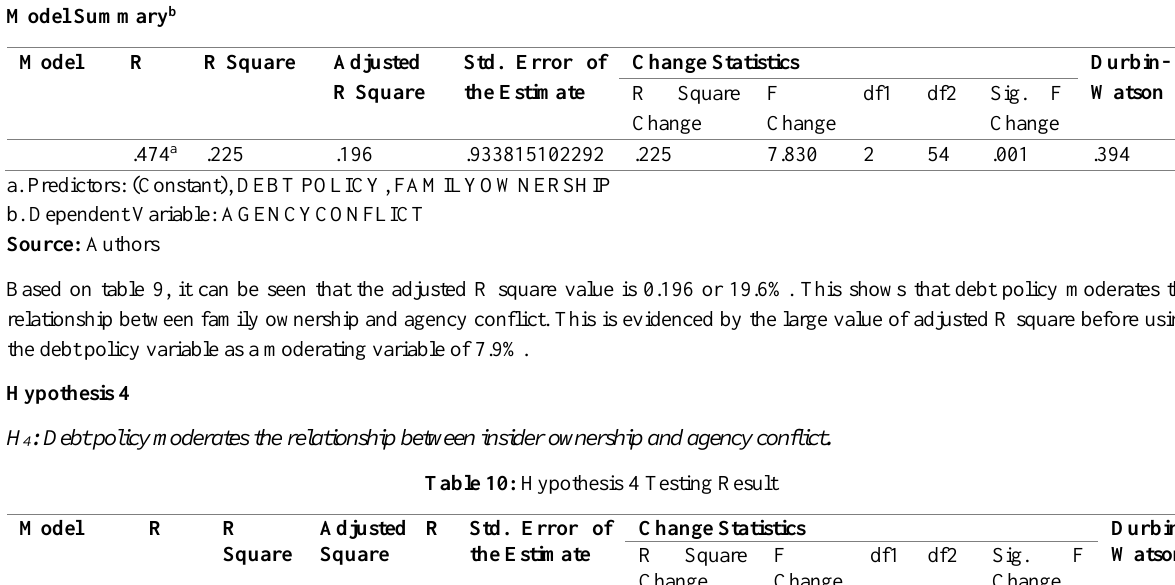
Table 9: Hypothesis 3 Testing Result